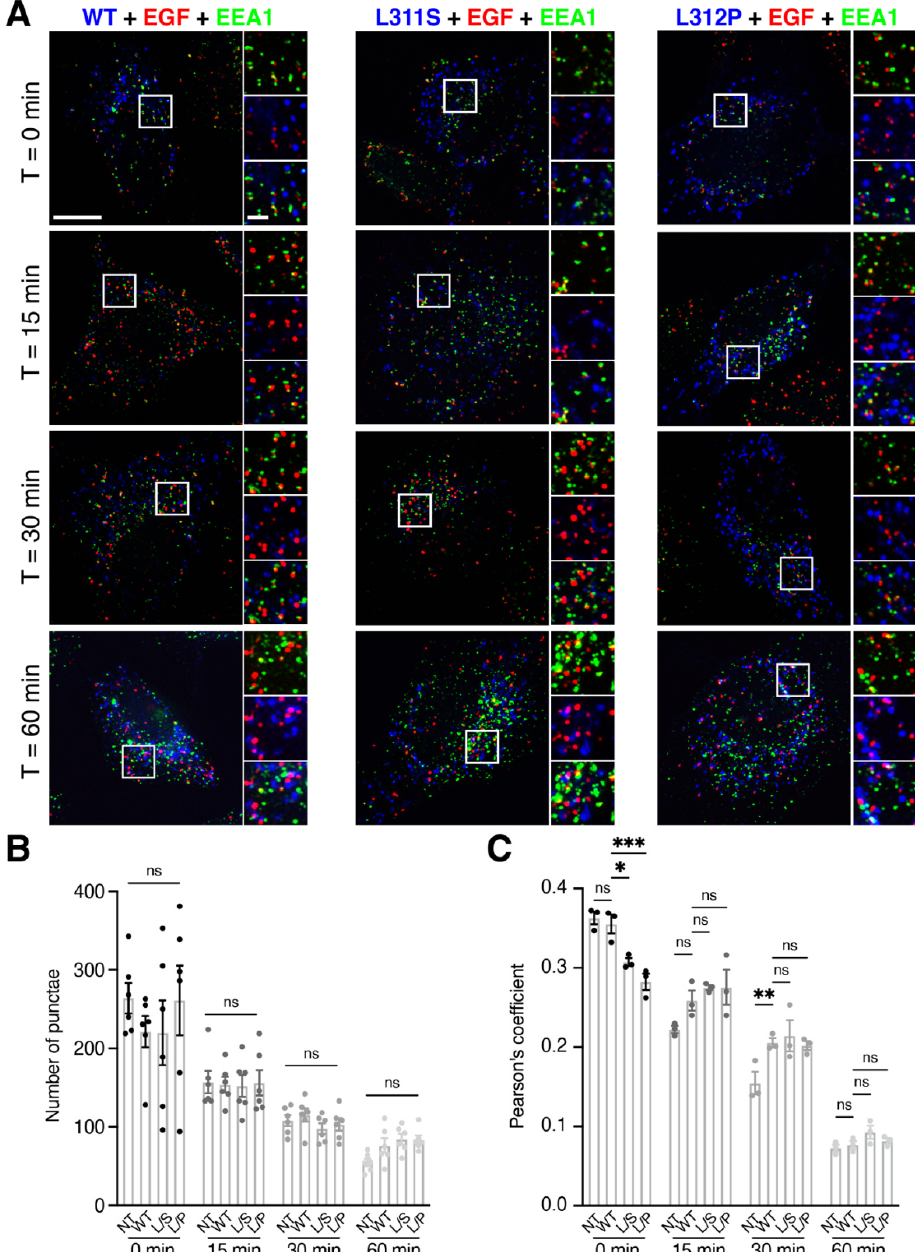
Figure 2. RNF13 variants L311S and L312P alter EGF sorting at early endosomes. ( A – C ) Starved HeLa cells transiently expressing RNF13-HA WT, L311S, or L312P were incubated with EGF for 5 min. Live cells were washed and incubated in fresh culture medium for the indicated time before being fixed, permeabilized, and labeled with specific primary antibody against HA (RNF13) and endogenous EEA1. ( A ) Representative images show EGF (red) with RNF13 (blue) and early endosome marker EEA1 (green). Scale bar = 10 µ m. Boxed areas are shown at higher magnification (scale bar = 2 µ m). ( B ) Quantitation of the average number of EGF puncta per cell. The bar graph presents the mean ± SEM while the strip plot represents the distribution of the average number of EGF puncta for each independent experiment. Analyses were performed on 6–9 cells within 5 fields of view collected for each of the six independent experiments (N = 6, total of 41 to 50 cells per condition). Not significant (ns) using two-way ANOVA with multiple comparison. ( C ) Quantitation of overlap between EGF and EEA1. The bar graph presents the mean ± SEM while the strip plot represents the distribution of the averaged Pearson’s coefficient of each independent experiment analyzed (N = 3). Each condition contains 37 to 45 cells. Not significant (ns), * p = 0.0155, ** p = 0.0093 or *** p = 0.0002 using two-way ANOVA with multiple